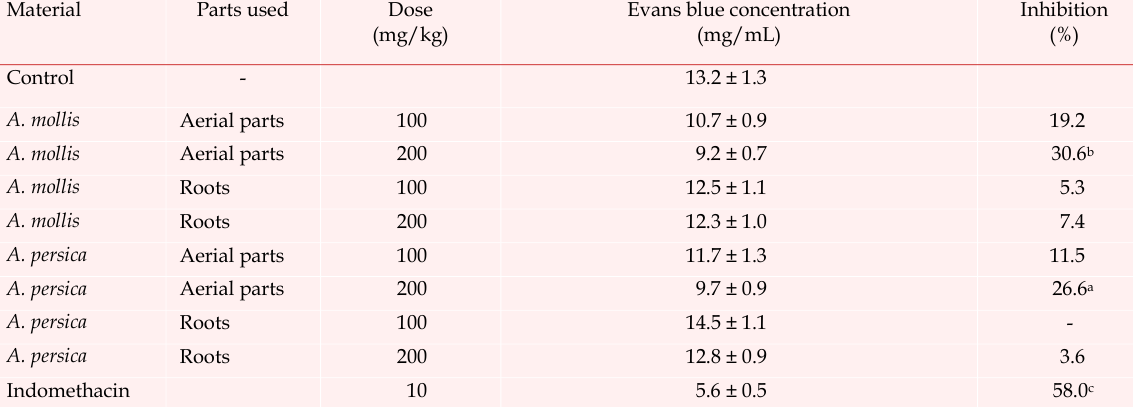
Inhibitory effect of the extracts of A. mollis and A. persica on acetic acid-induced increase in capillary